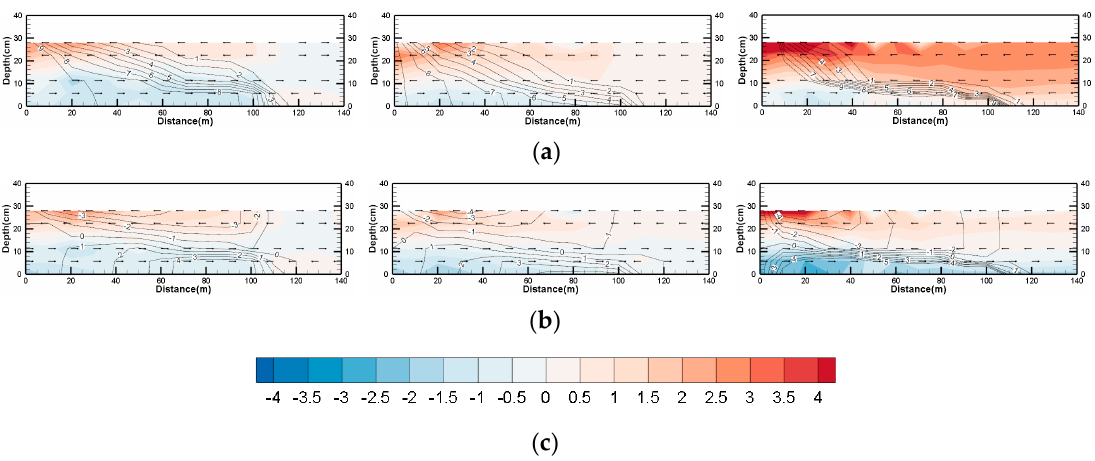
Figure 11. Residual circulation and gravitational circulation profiles of Case 3 (left figures), Case 4 (middle figures) and Case 5 (right figures). ( a ) Residual circulation profiles; ( b ) Gravitational circulation profiles; ( c ) Legend of velocity (unit: cm/s). The arrow represents the flow direction. The contour represents the isohaline.